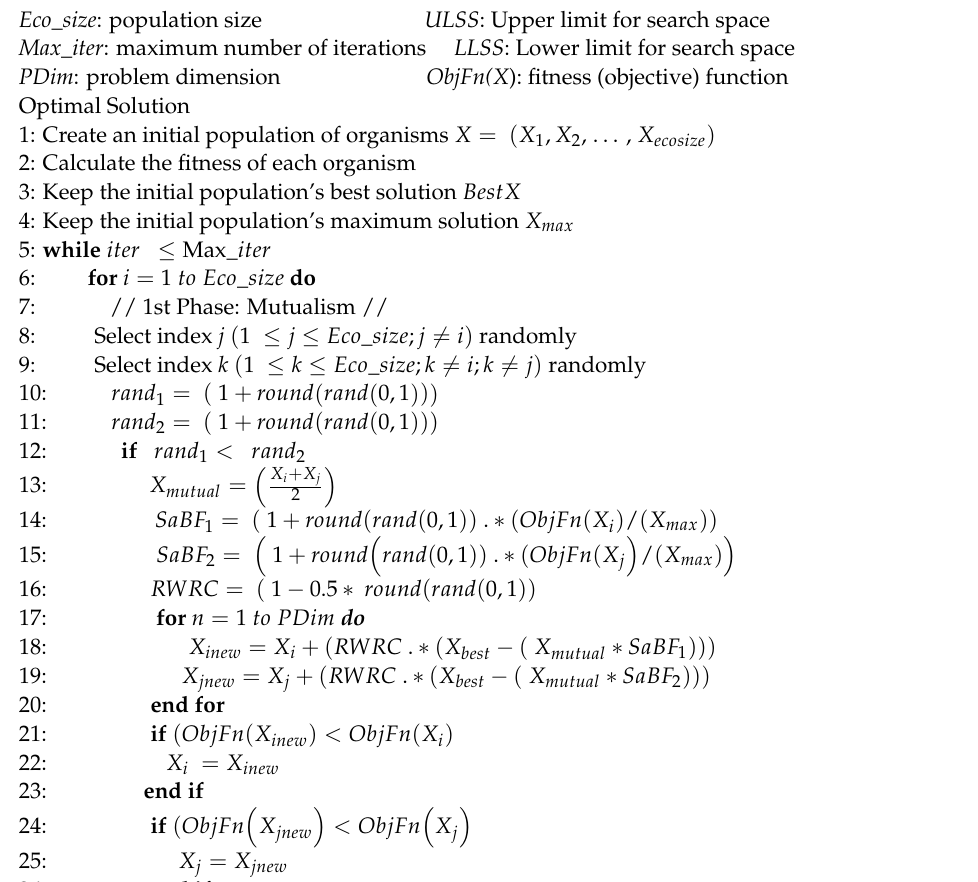
Algorithm 2 : The proposed improved SOSK-means